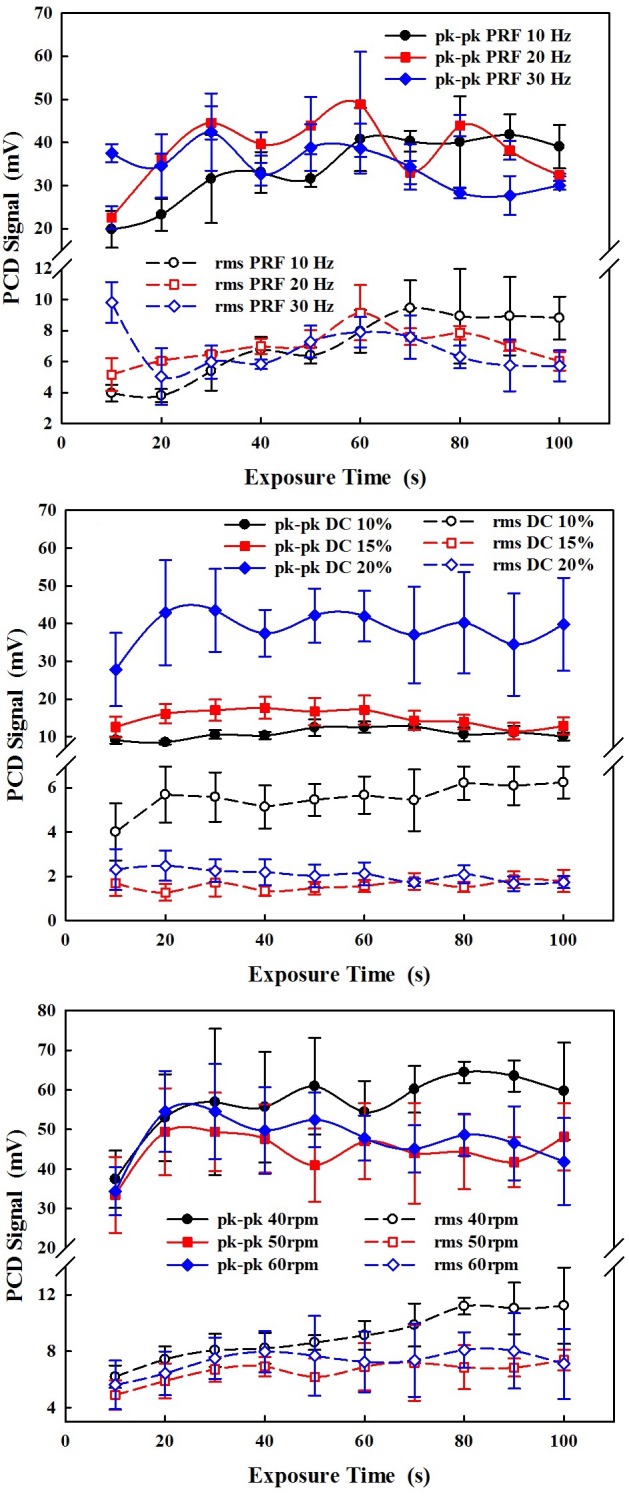
Variation of peak-to-peak and root mean square (rms) passive cavitation detection (PCD) signals during 10 s HIFU exposure from tubing 1 with the circulating degassed water (a) at varied pulse repetition frequency (PRF) of 10 Hz, 20 Hz, and 30 Hz, (b) at the varied duty cycle (DC) of 10%, 15%, and 20%, and (c) at the varied rotation speed of 40, 50, and 60 rpm. The control operation parameters are the PRF of 10 Hz, DC of 20%, and pump speed of 60 rpm.